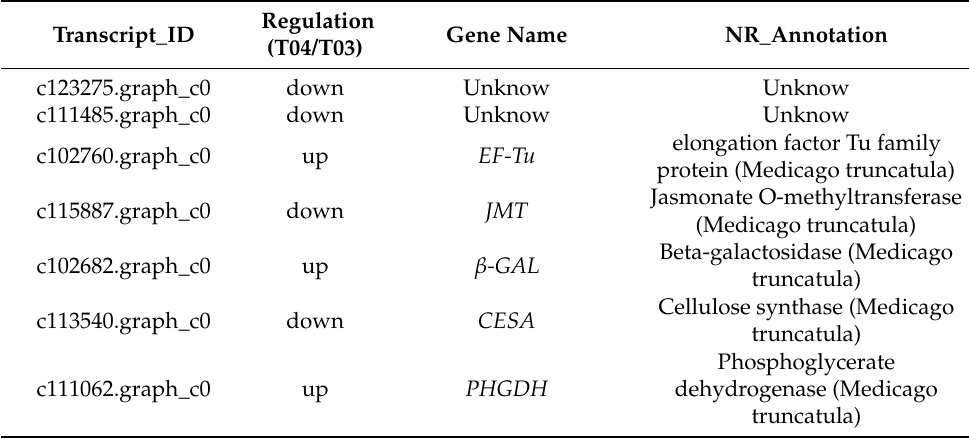
Table 5. The 7 candidate genes identified by BSR.